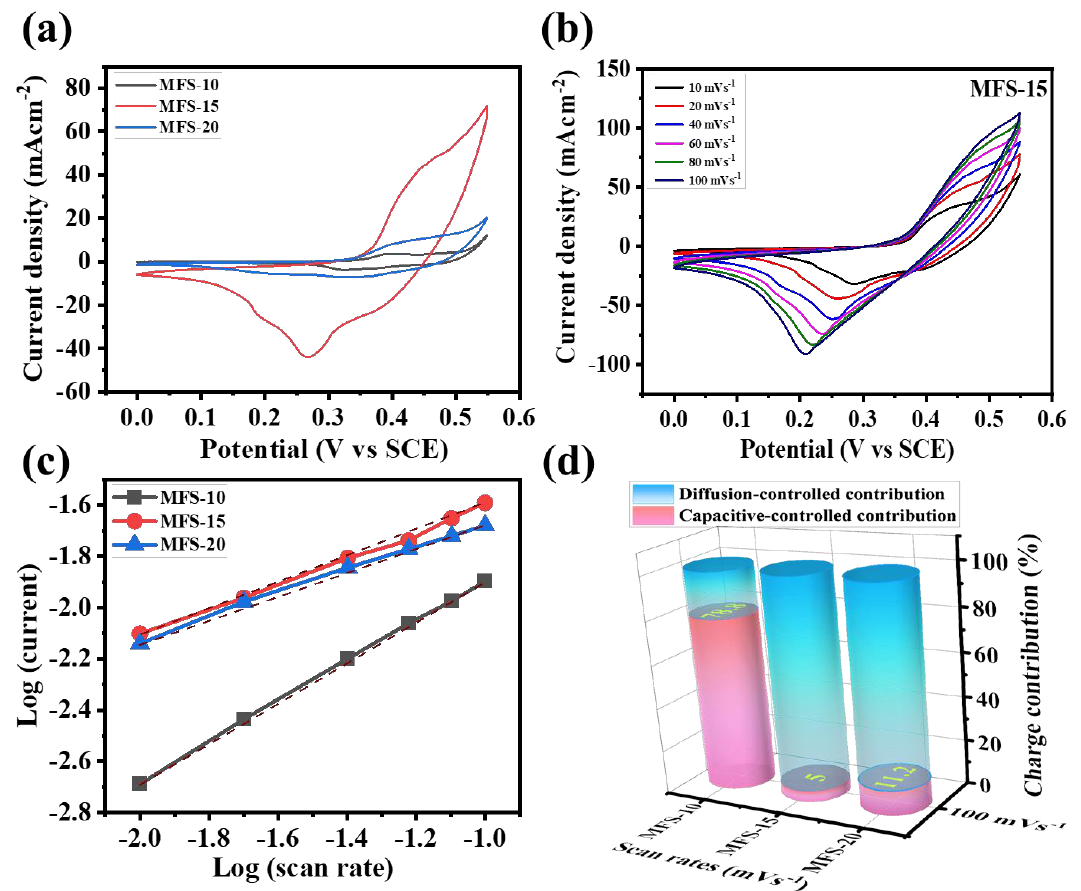
Figure 4. Cyclic voltammetry graphs measured in 1M KOH electrolyte ( a ) MFS electrode measured at 10 mV s − 1 scan rate, ( b ) MFS-15 electrode at different scan rates (10–100 mV s − 1 ), ( c ) Graph of log (current) vs. log (scan rate) for determining b–value, and ( d ) distinguishing capacitive and diffusive-controlled contribution of MFS electrodes at 100 mV s − 1 scan rate.